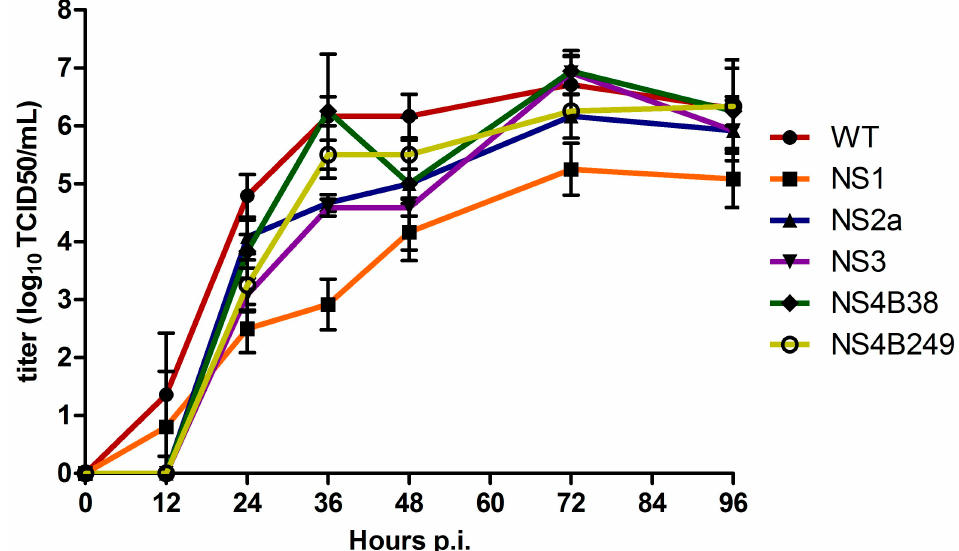
Figure 2. Growth kinetics of infectious virus of the wild type (WT) virus and mutant viruses after triplicate infection of Vero E6 cells at an MOI of 0.1. The titres are given as the mean (log10 TCID 50 /mL); error bars represent standard deviation.